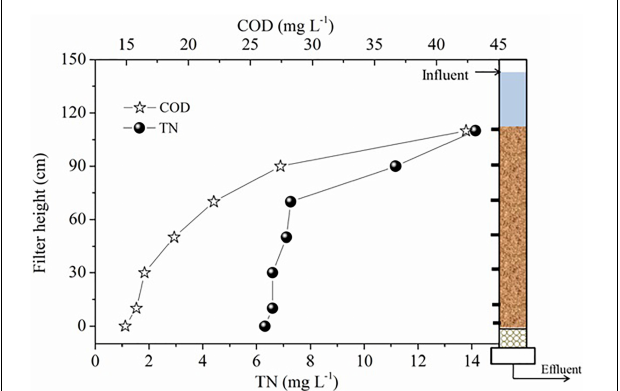
FIGURE 3 | Concentration profiles of TN and COD along the DN-DBF